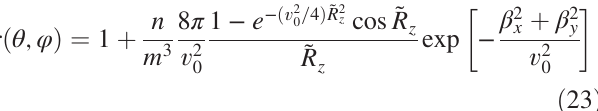
FIG. 1. Angular dependence of the logarithmic intensity emitted by a molecular gas at large cooperation number ¯ r ≫ 1 in a slab-shaped container with dimensions ˜ R 1 , whose orientation is depicted by the blue prism. The z ¼ intensity is exponentially peaked in the directions close to the normal vector of each of the faces, and it is largest, by far, along the z direction, perpendicular to the two largest faces of the container. For illustrative purposes, we pick v 0 ¼ 10 − 2 and 0 , while we also exaggerate the thickness of the v lab ¼